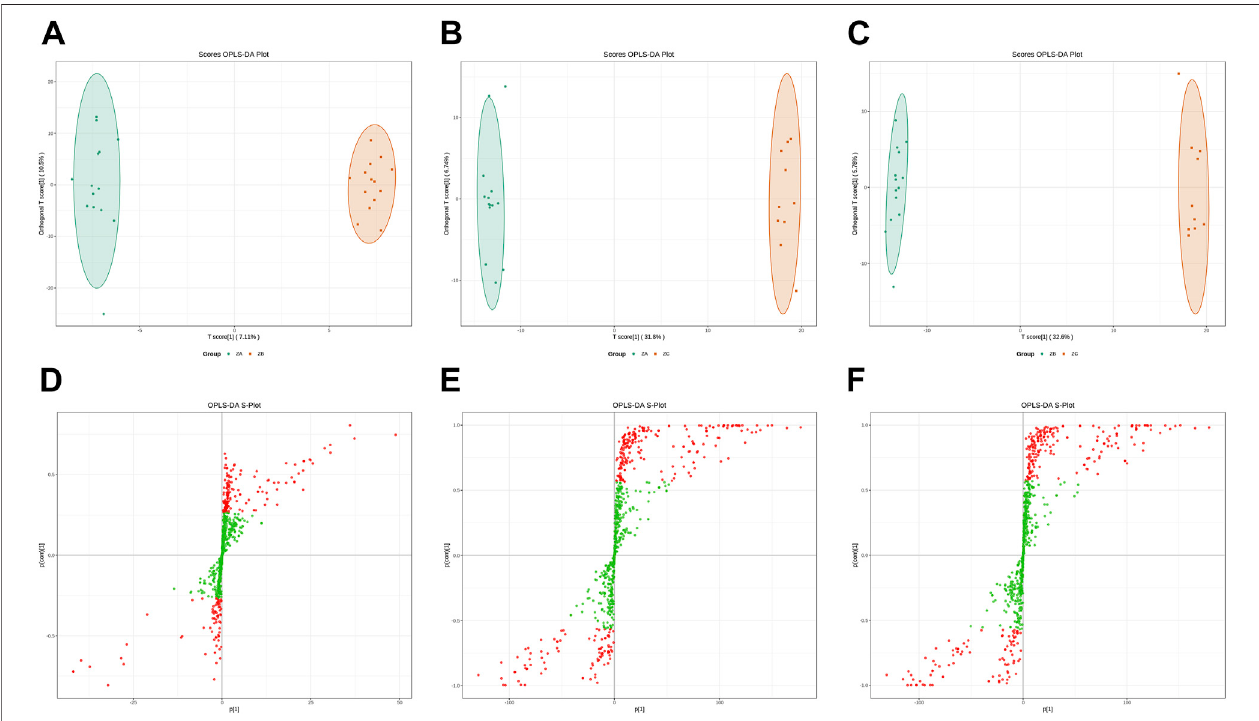
FIGURE 2 | Serum metabolites identi fi cation based on the orthogonal partial least-squares discrimination analysis (OPLS-DA). ( (A) Serum metabolites score plot based on OPLS-DA betweenZA and ZB; (B) serum metabolites score plot based on OPLS-DA between ZA and ZC; (C) serum metabolites scoreplot based on OPLS- DA between ZB and ZC; (D) S-plot between ZA and ZB; (E) S-plot between ZA and ZC; (F) S-plot between ZB and ZC; ZA, ZJP after treatment; ZB, ZJP before treatment; ZC, ZJP control as healthy